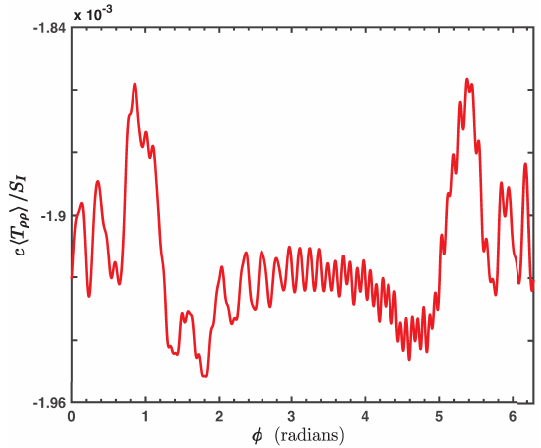
Figure 6. Radial force on the filament surface normalized to the power flux of the incident wave versus the azimuthal angle. The incident wave is an O mode and the parameters are the same as for figure